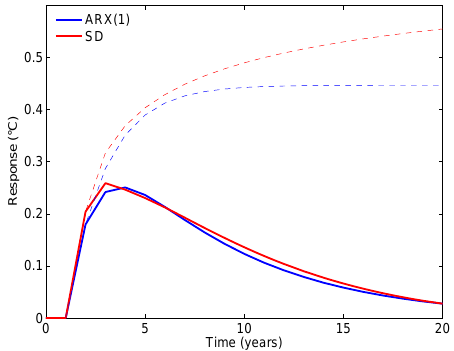
Figure 7. Time-domain response of the first-order linear (ARX(1); Eq. 6) and the semi-infinite diffusion model (SD; inverse Laplace transform of Eq. 8) due to a step change in radiative forcing at t = 1 year. Parameter values for the models are the same as in the text and the caption of Fig. 4. Dashed lines show the open-loop re- sponse, and solid lines show the closed-loop response with k i = 0.4 and k p =